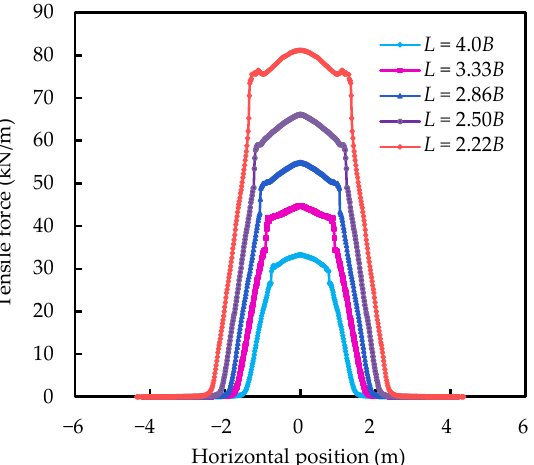
Figure 10. Tensile force distribution of the geotextile for the different subsidence widths.